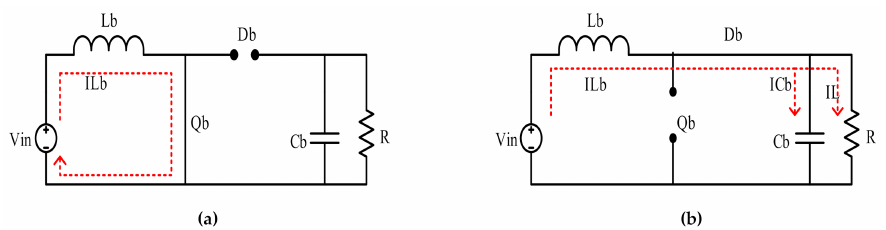
Figure 4. CCM-boost converter operation modes. ( a ) Switch Q b closed, ( b ) Switch Q b